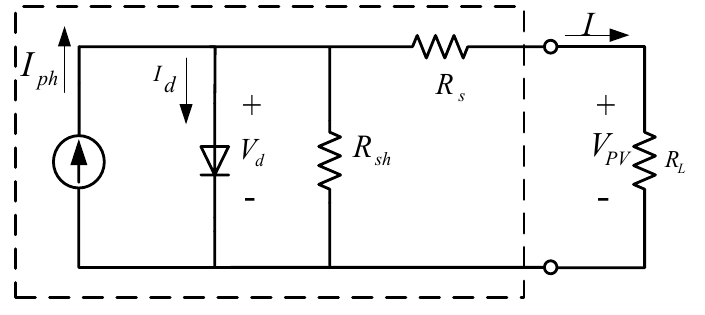
Figure 2. The equivalent circuit of a solar